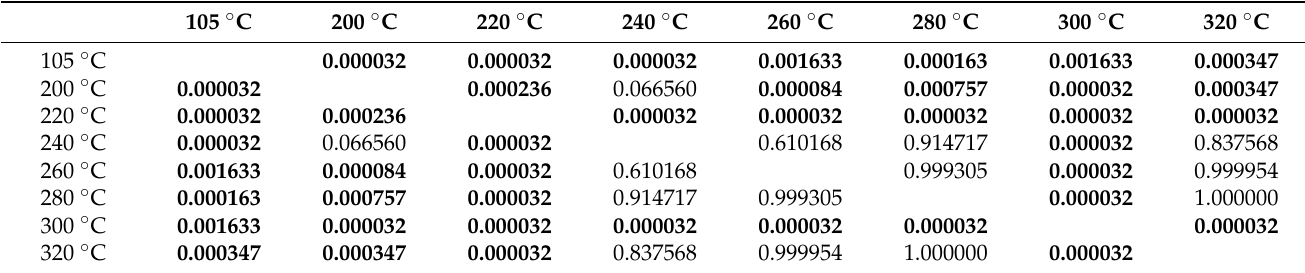
Table A4. Significant differences for the EMC variable for the effect of torrefaction temperature (TT) according to Tukey’s test (HSD) for butternut-squash